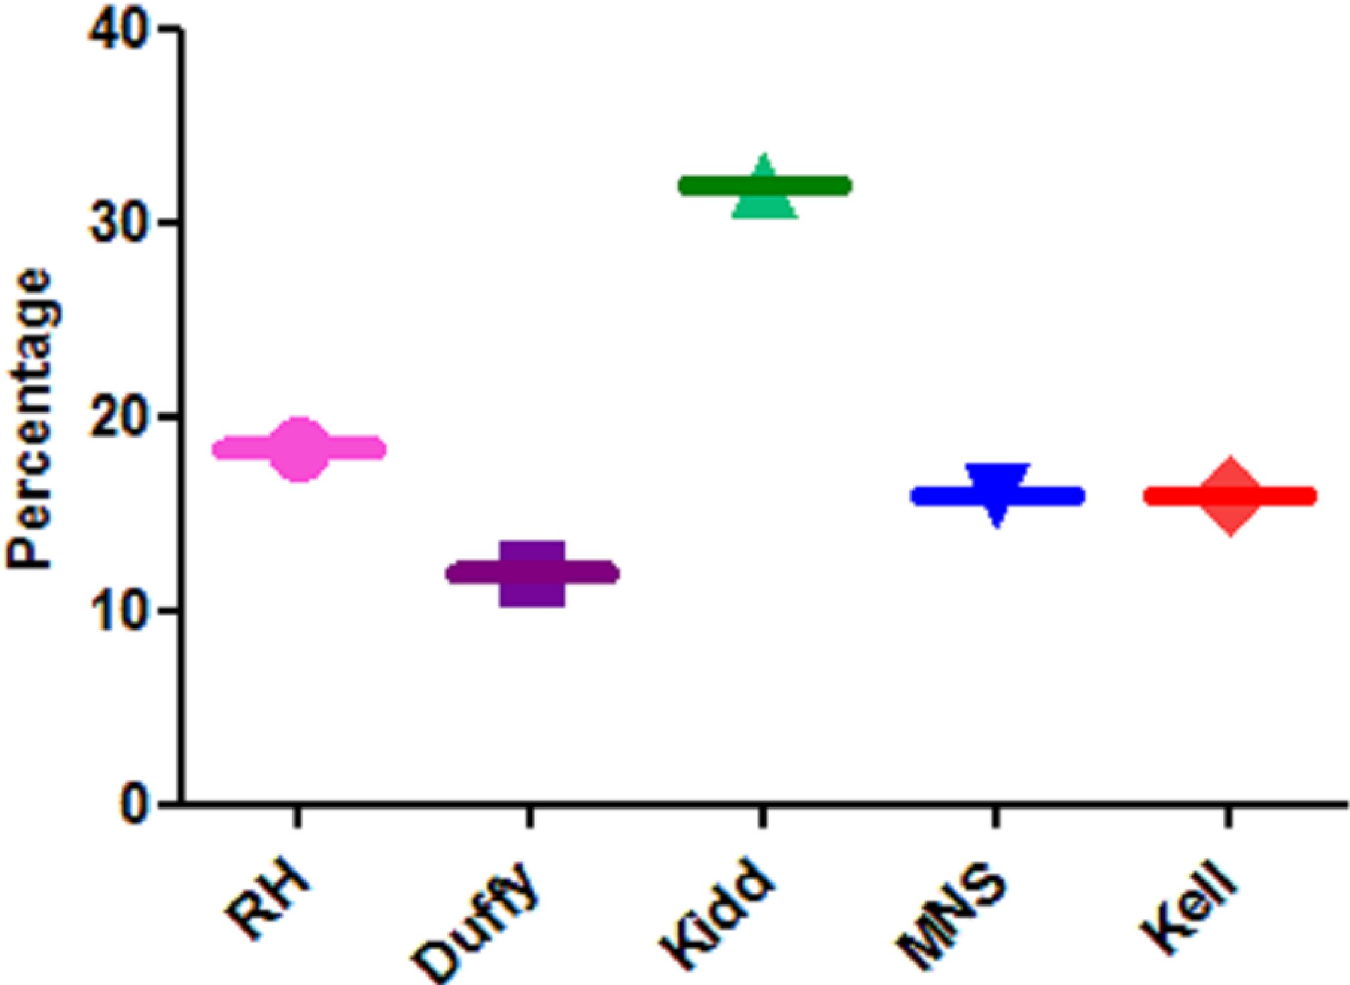
Fig 6. Frequency of mixed field results among group 2 patients for each non-ABO blood group system.